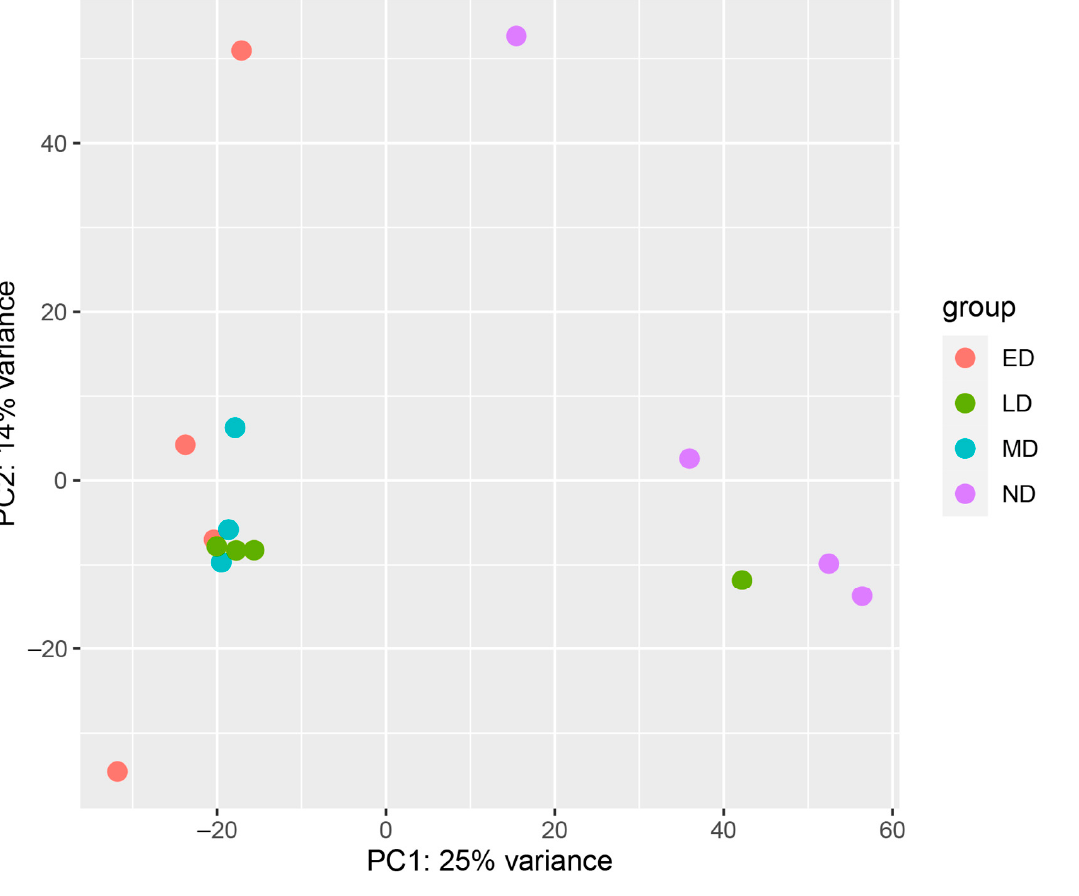
Figure 1. Principle Component Analysis (PCA) score plots of samples. This PCA was used to determine the relationship between transcript expression profiles from various stages of